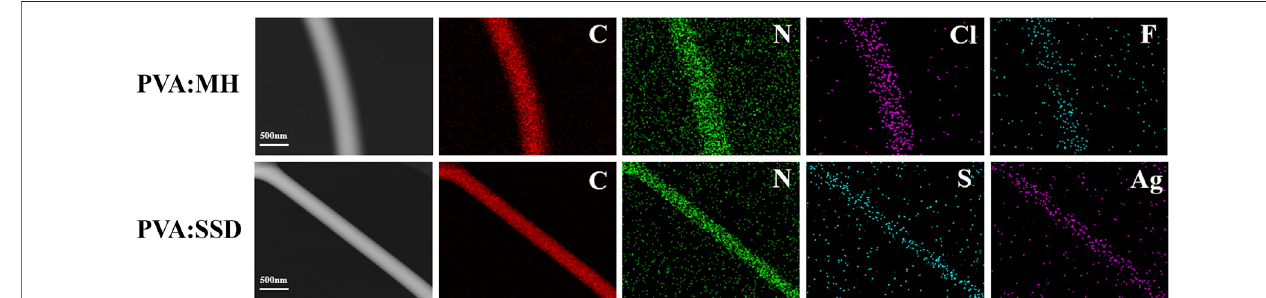
FIGURE 2 | TEM images and the elemental mapping images of PVA: MH and PVA:SSD.